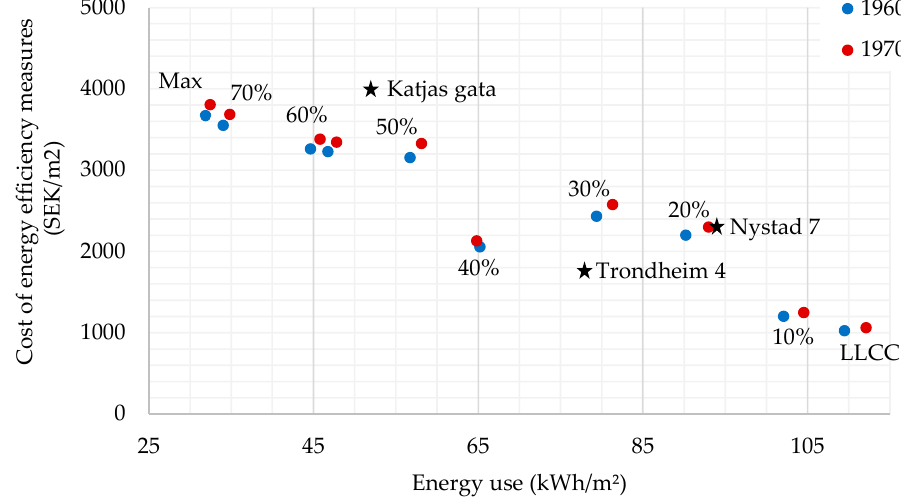
Figure 6. Cost of energy renovation per apartment area at the different energy saving targets compared to three other energy renovated buildings from the 1960s and the 1970s (presented in Table 1).